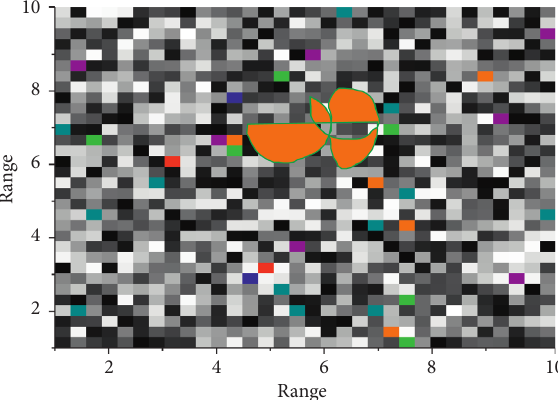
Figure 5: Simplified model of levels and pivots.